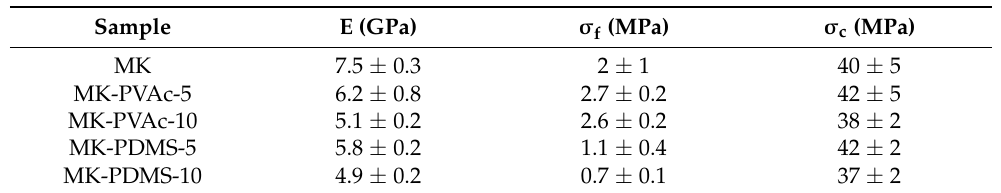
Table 5. Mechanical properties of the investigated samples: dynamic elastic modulus (E), flexural strength ( σ f ), and compressive strength ( σ c ).